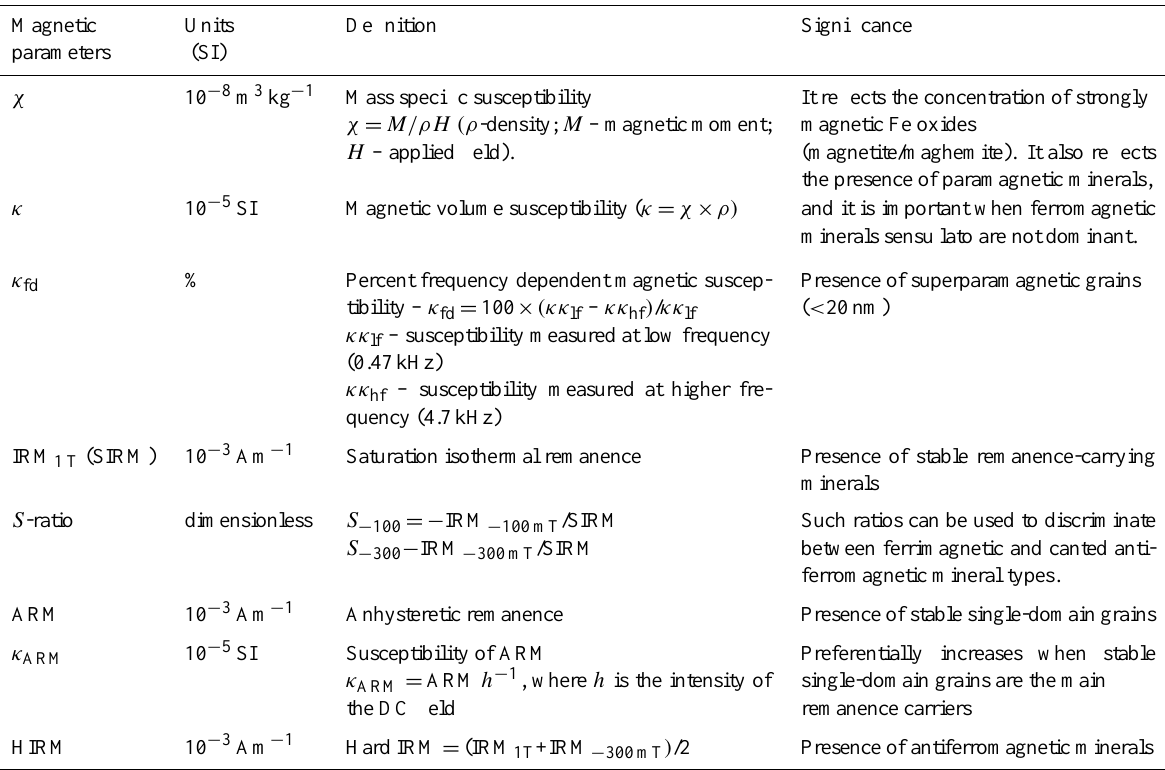
Table 1. Magnetic parameters referred to in the text and their basic interpretation (according to Jordanova et al., 2010; Walden and Ballantyne, 2002).